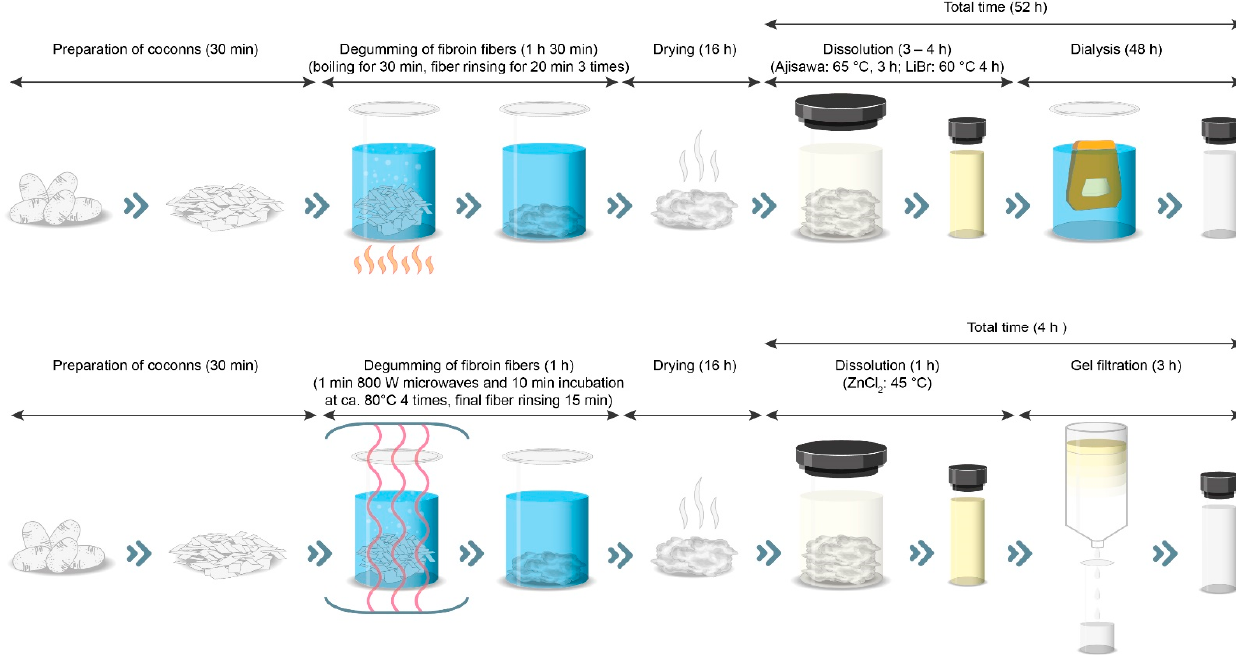
Figure 10. Comparison of the standard process for the production of regenerated silk fibroin ( above ) with the presented ZnCl 2 -based faster process ( below) .